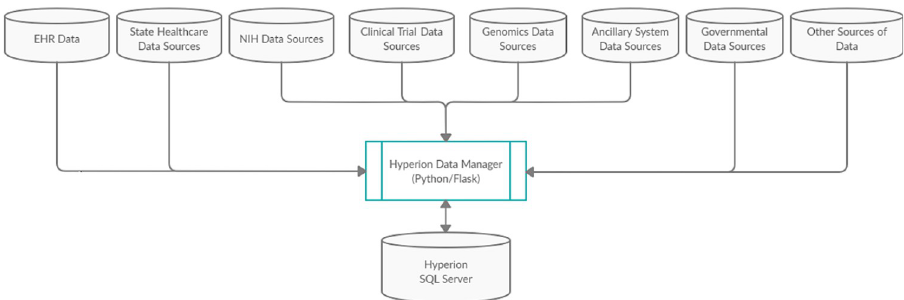
Fig 1. Current architecture of Wilmot Cancer Institute (WCI) data warehouse.